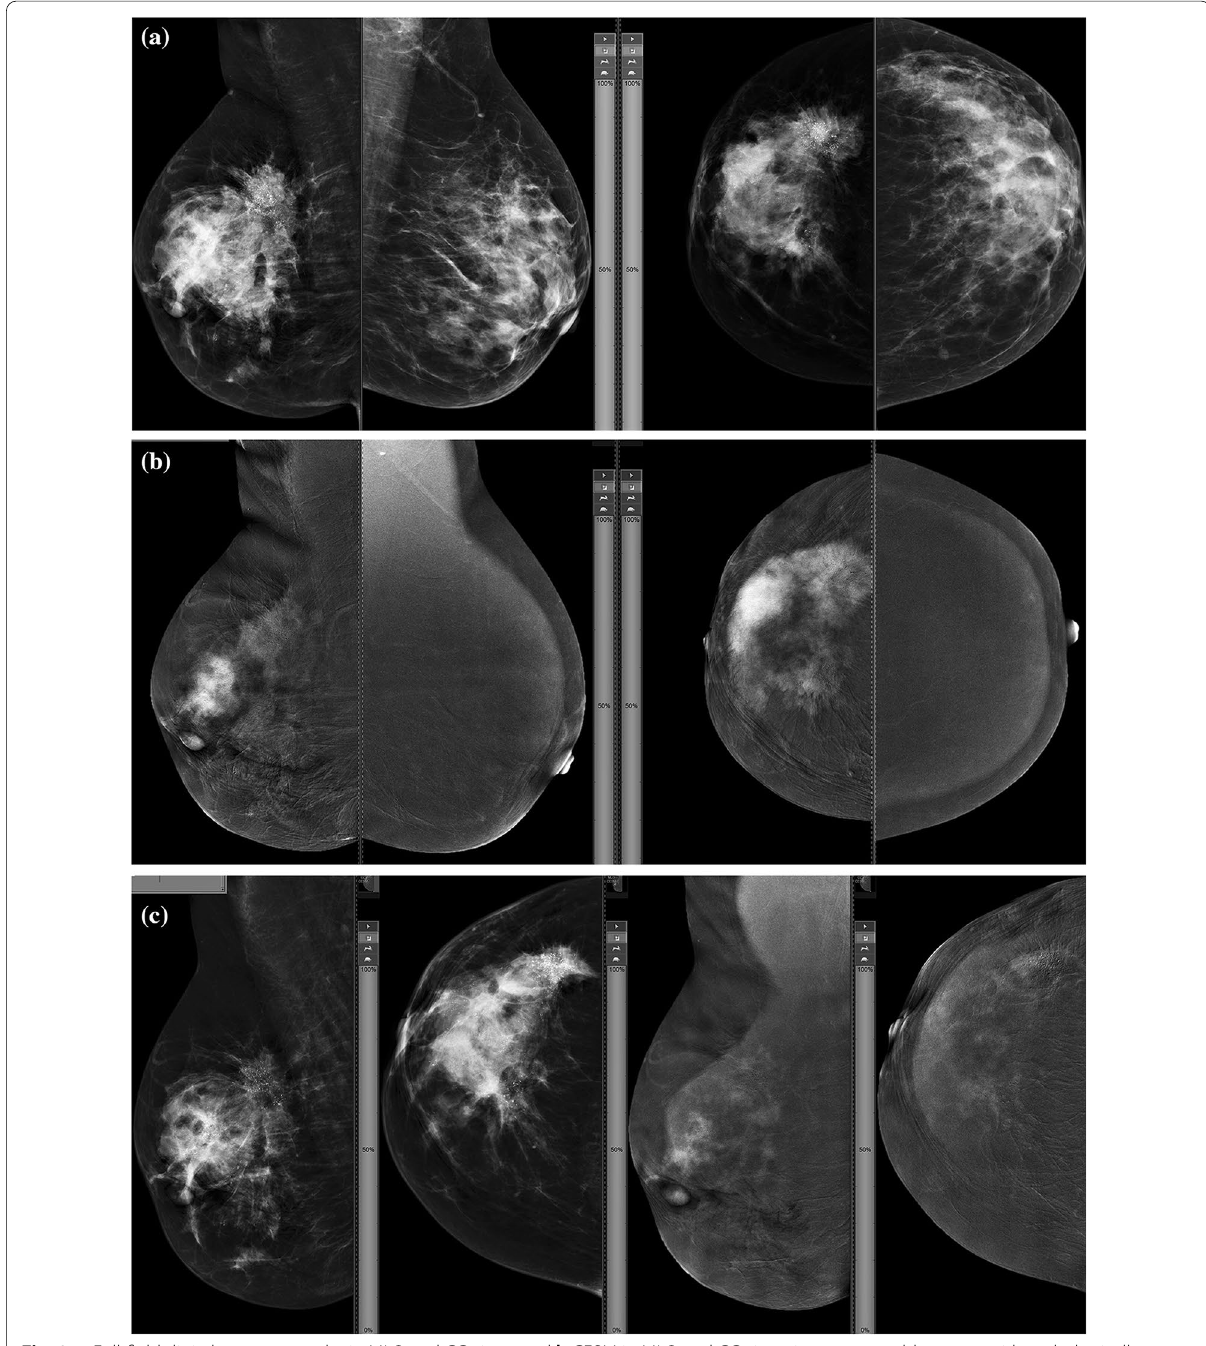
Fig. 2 a Full‑field digital mammography in MLO and CC views and b CESM in MLO and CC views in a 45‑year‑old woman with pathologically proven invasive duct carcinoma showing a heterogeneously enhancing malignant infiltration with speculated outline occupying the UOQ of the right breast and to a lesser extent to UIQ measuring 11.7 cm in longest diameter. c Follow‑up full‑field digital mammography in MLO and CC views and CESM in MLO and CC of the right breast after neoadjuvant chemotherapy. The tumor now measures about 8.2 cm in longest diameter indicating a PR with a 30% reduction in tumor size which was confirmed on histopathology examination following a right modified radical